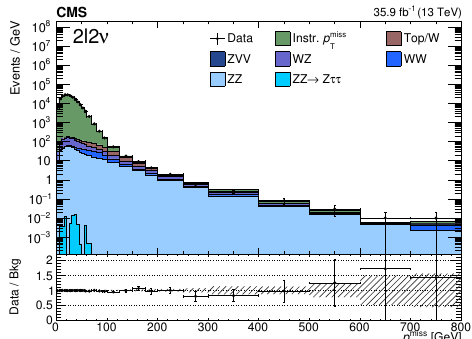
Figure 9 . Distribution of the missing transverse energy p miss points represent the data and the stacked histograms the expected backgrounds. The lower panel shows the ratio between data and background